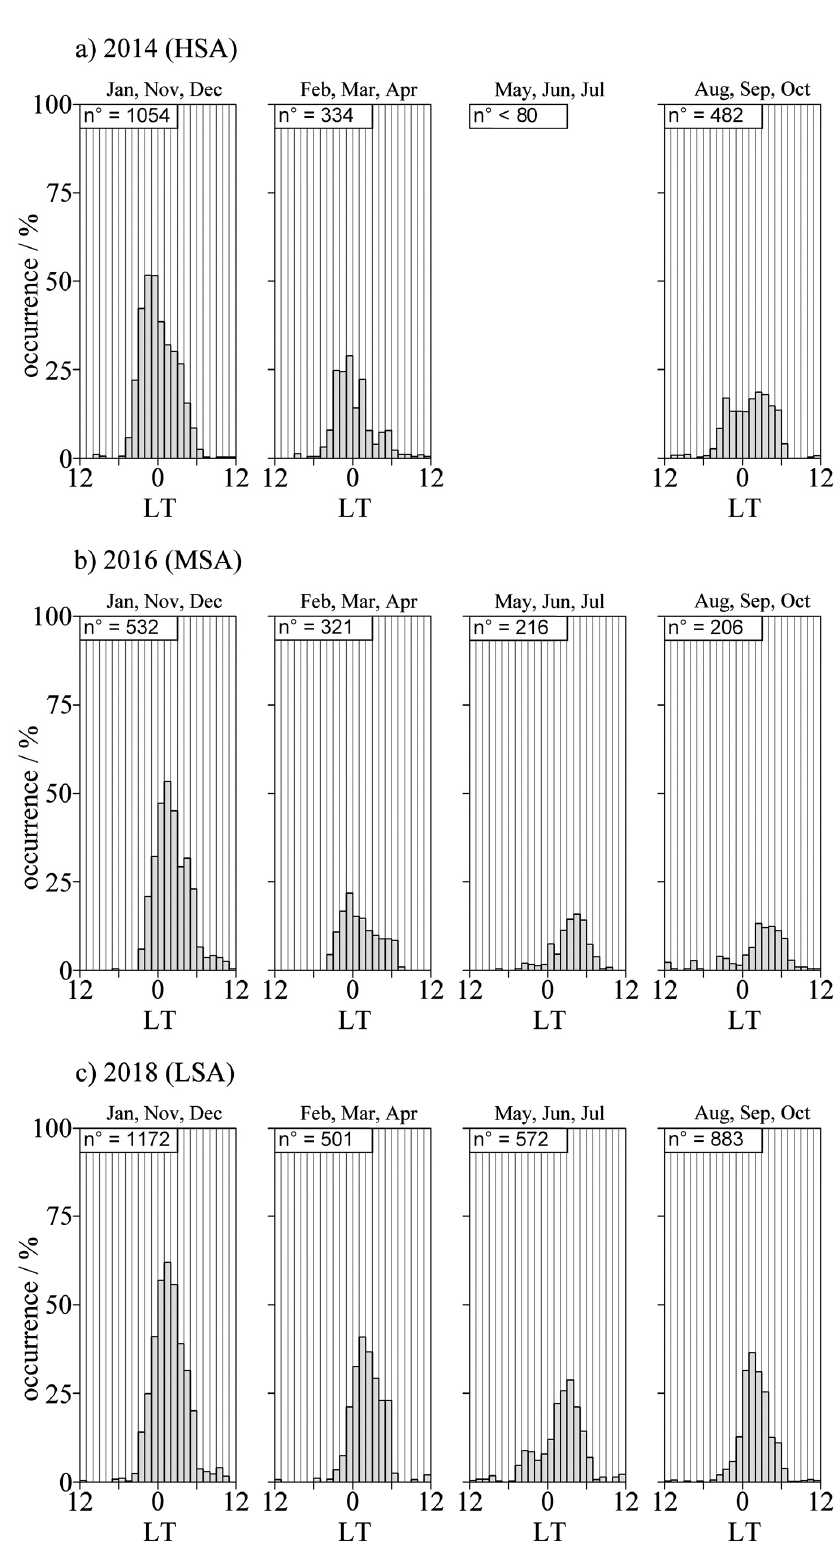
Figure 3. The occurrence of spread F as a function of LT in 2014 (HSA) ( a ), 2016 (MSA) ( b ), and 2018 (LSA) ( c ), for 7 ≤ a p < 27. Only the histograms derived from more than 80 cases of spread F are shown.